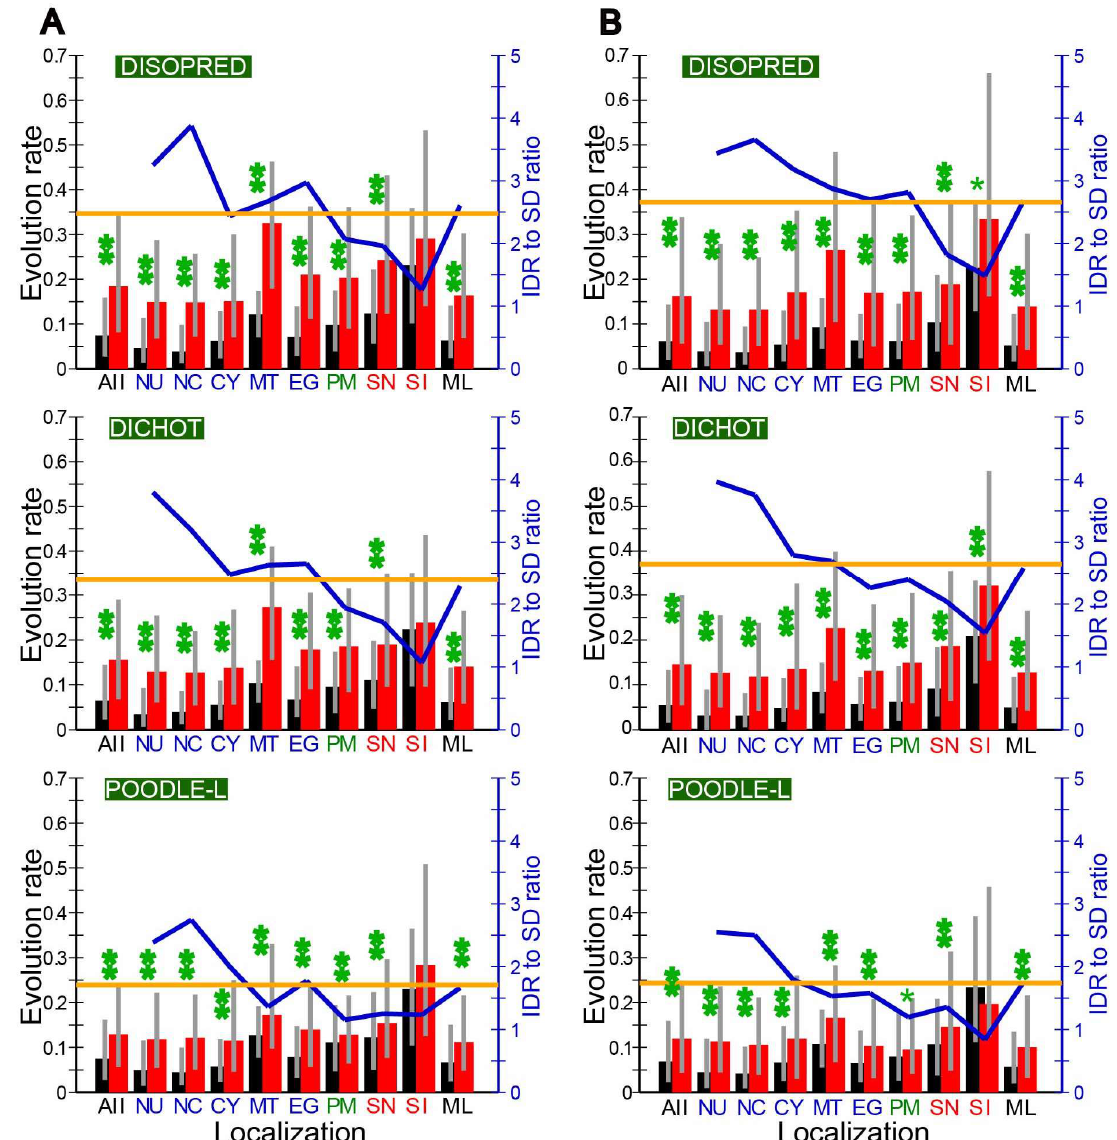
Figure 3. Evolution rates are higher in IDRs than in SDs except possibly for immune-related secreted proteins in mammals. ( A ) H. sapiens ; ( B ) M. musculus ; the diagrams (top to bottom) in each panel are based on DISOPRED, DICHOT and POODLE-L predictions. The median evolution rates in SDs are shown in black rectangles, while those in IDRs are depicted in red (left scale). Grey vertical lines show ranges from the 25th to the 75th percentile. Blue lines represent the median evolution rate ratios of IDRs to SDs at respective localizations, while horizontal orange lines show the ratio of all proteins (right scale). One asterisk signifies a statistically significant difference between the evolution rate distributions of IDRs and SDs at p < 0.01, while two asterisks denote a statistically significant difference at p < 0.001 ( U -test). The same abbreviations for localizations as those in Table 1 are used. In the cytosolic proteins (CY) of budding yeast, the median evolution rate in IDRs was only a